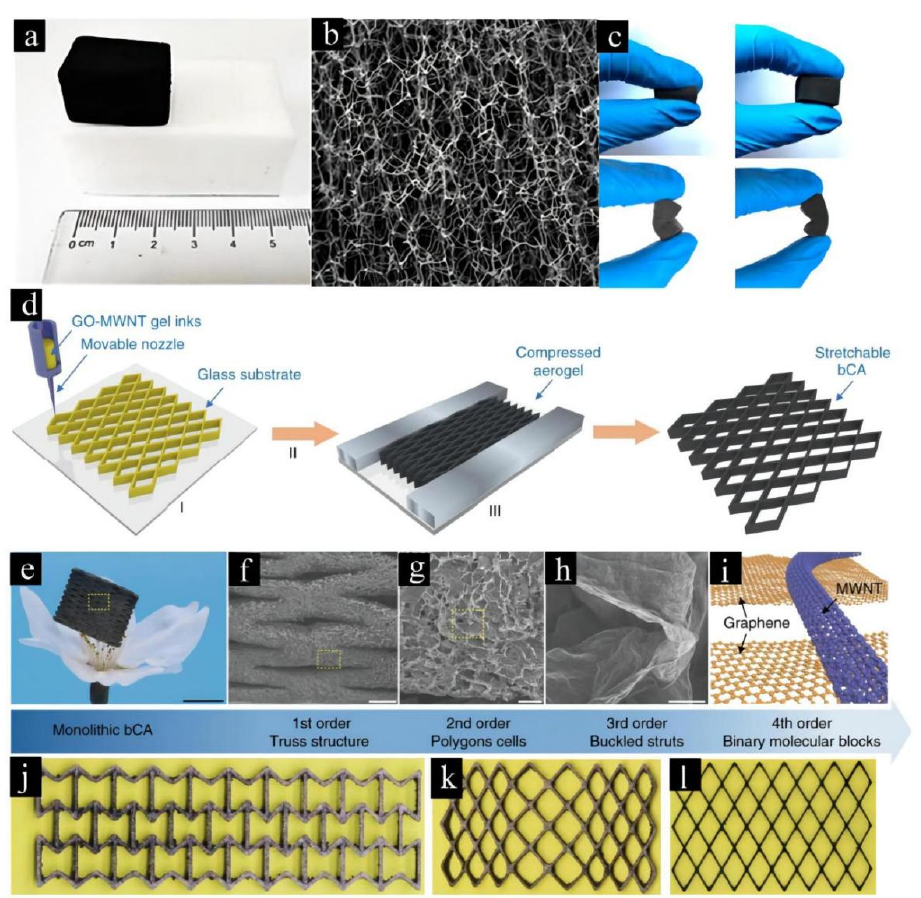
Figure 4. ( a ) Image of melamine foam and CF. ( b ) FESEM image of the CF. ( c ) CF compressed and bent by finger. ( a – c ) Reprinted with permission from [6]. Copyright Elsevier Publisher, 2021. ( d ) Schematic of the CA assembly by 3D printing (I), freeze-drying (II) and reduction (III). ( e ) Image of CA balancing on a flower. ( f – i ) SEM images of CAs in various size scales. ( j – l ) Printed structures with negative ( − 0.3, ( g )), positive (+0.5, ( h )) and zero Poisson ratio (0, ( l )). Scale bars, 5 mm ( e ), 500